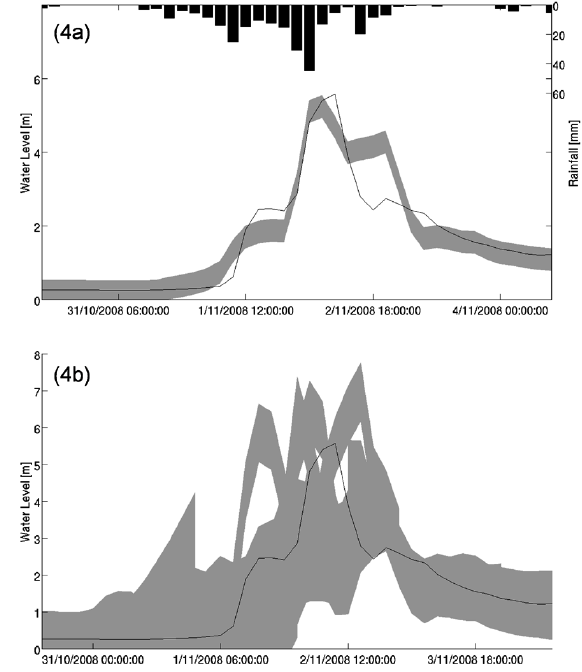
Fig. 4. Twelve hour ahead predictions of water level at Anduze during a flood event in November 2008. The black line shows the observed water levels. On the top panel (a) the forecasts are driven with observed precipitation as input (shown on top). The shaded area represents the expected value of the prediction ± 3 standard deviations. The bottom panel (b) shows the corresponding predic- tions when the DBM model is driven by the corrected COSMO- LEPS rainfall forecasts. The shaded area represents the prediction intervals (as for (a) ) for each of the ensemble